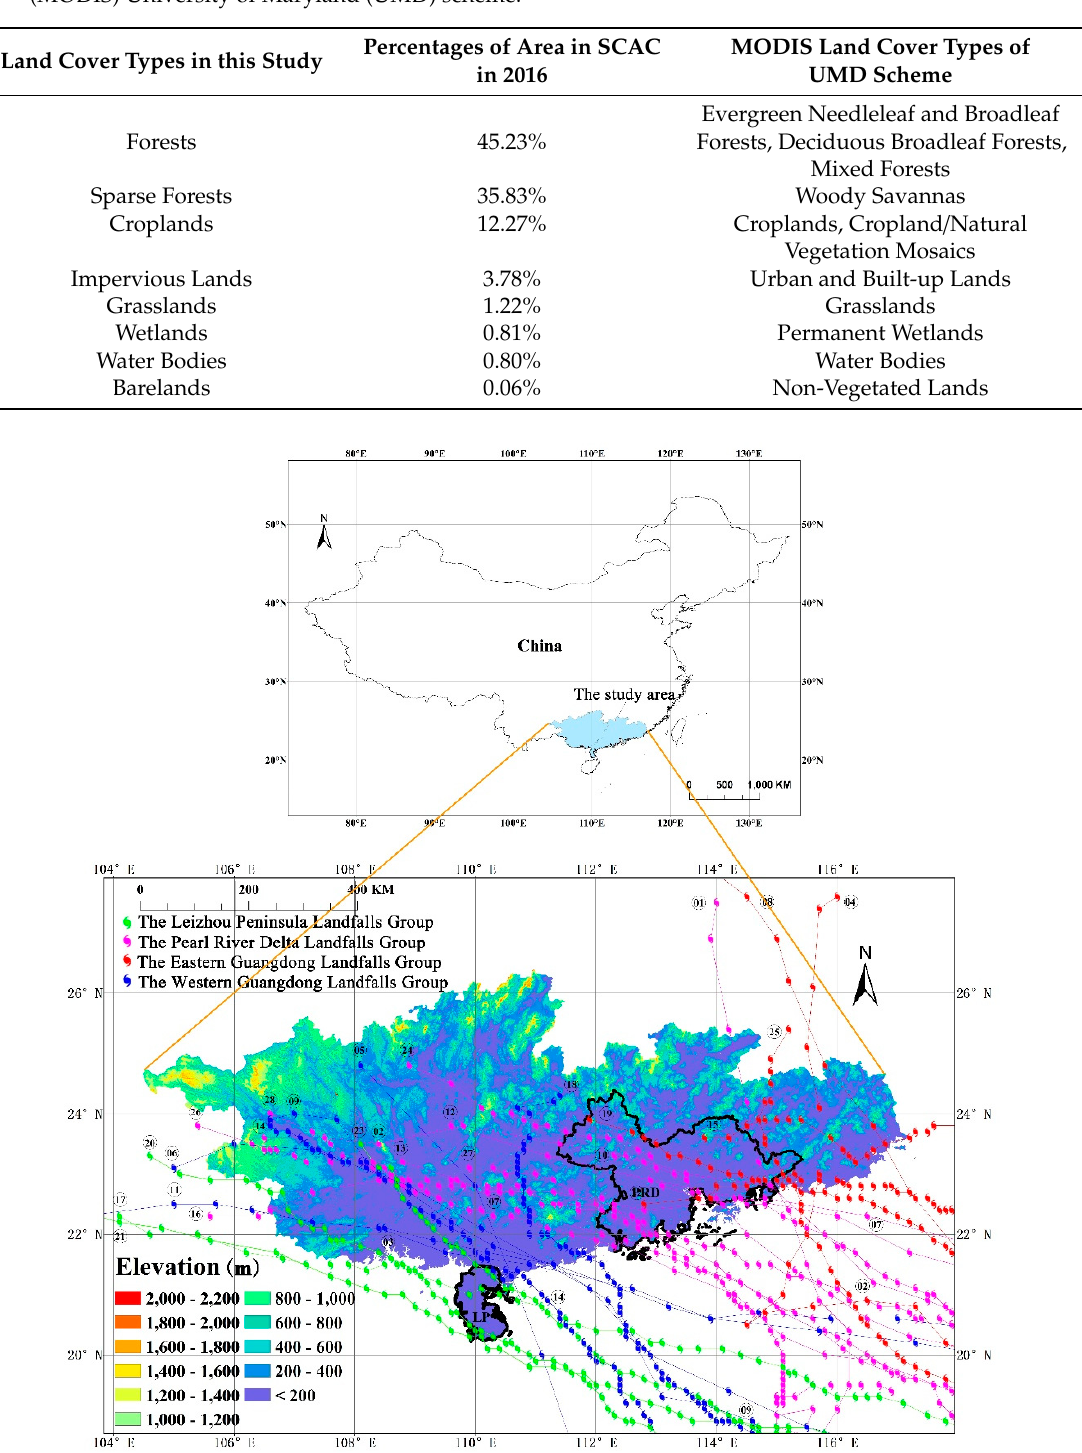
Table 2. Land cover types in this study and the moderate resolution imaging spectroradiometer (MODIS) University of Maryland (UMD) scheme.